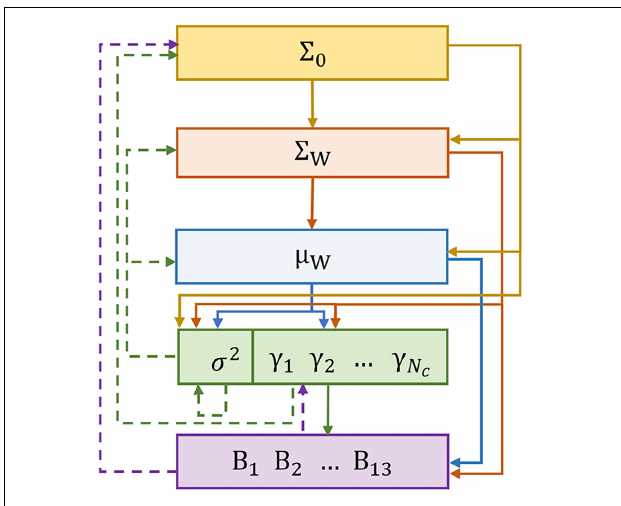
FIGURE 2 | Parameter relationship graphical model in a single iteration. Parameters of the same color can be iterated simultaneously.